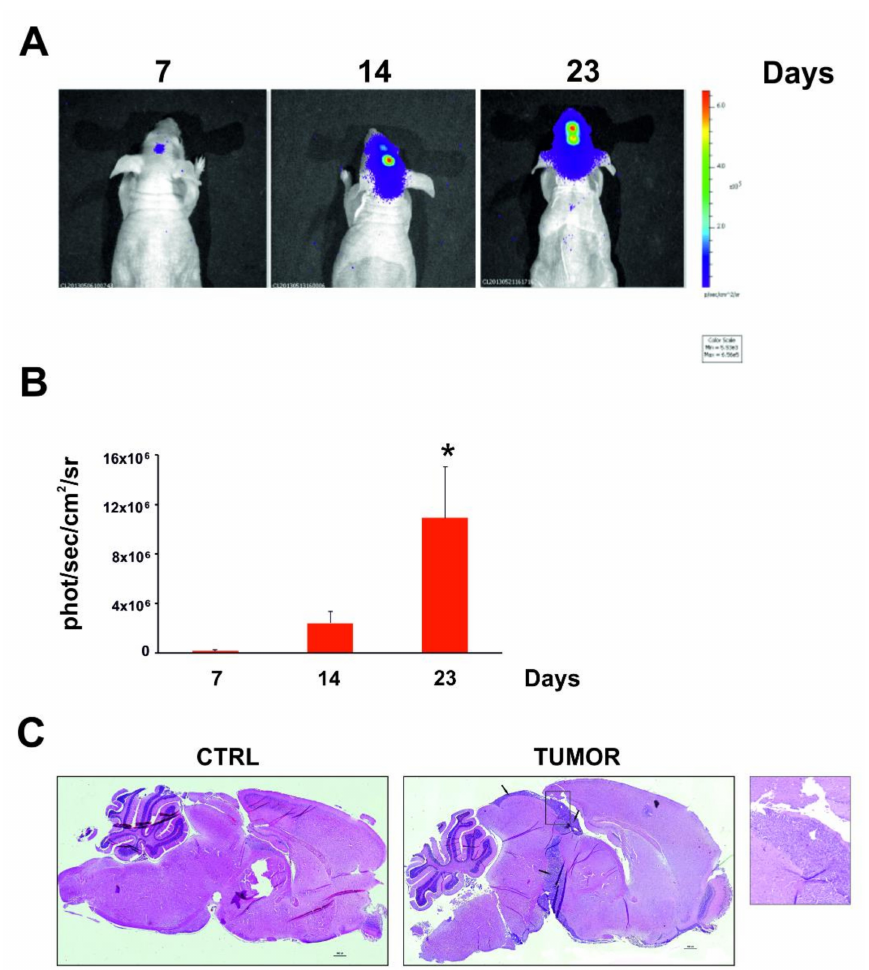
Figure 1. In vivo imaging of M14 metastatic melanoma cells transfected with pcDNA3-luc plasmid (M14-LUC stable cell line) intracranial xenografts. ( A ) Luminescence of M14-LUC cells intracranially injected in the mouse brain was monitored weekly using the In Vivo Imaging Systems (IVIS, 200 series, Caliper Life Sciences, Hopkinton, MA, USA). Mice were anesthetized to perform measurement of luminescence. Representative tumor images on day 7, 14 and 23 after tumor cell injection are shown. Data were acquired and analyzed using the Living Image Software version 3.0 (Caliper Life Sciences). ( B ) Histograms report bioluminescence at day 7, 14 and 23 after tumor cell injection. Error bars indicate ± SD. Unpaired-one-tailed student’s t test was used for statistical comparison between the di ff erent groups and the control (CTRL) group (* = p < 0.05). ( C ) Representative histopathological examination of mouse brains in control (CTRL) and tumor-bearing (TUMOR) mice after 23 days from tumor cell injection. Images shown are at 4 ×